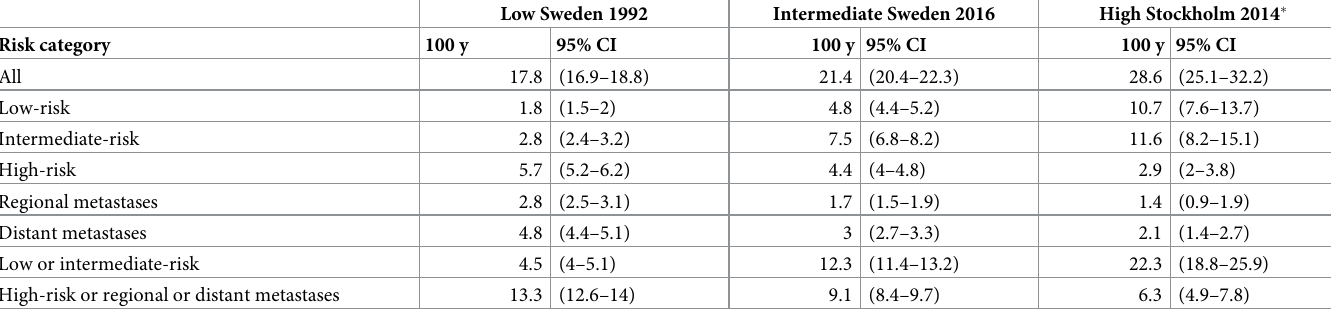
Table 1. Lifetime-risk of prostate cancer overall and per risk category according to intensity of diagnostic activity. Low Sweden